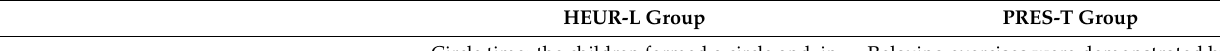
Relaxing exercises were demonstrated by the PE teacher.